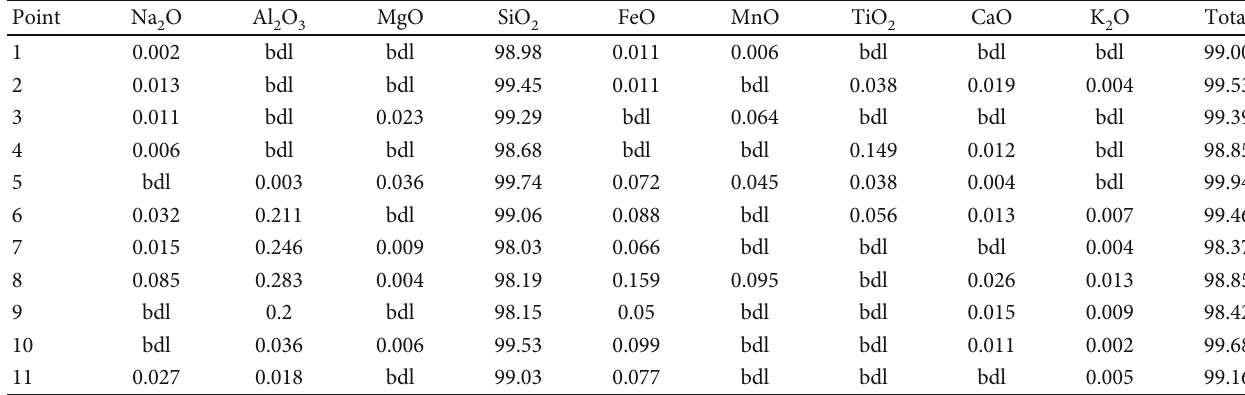
Table 2: Major element data for quartz in the D13 well (in